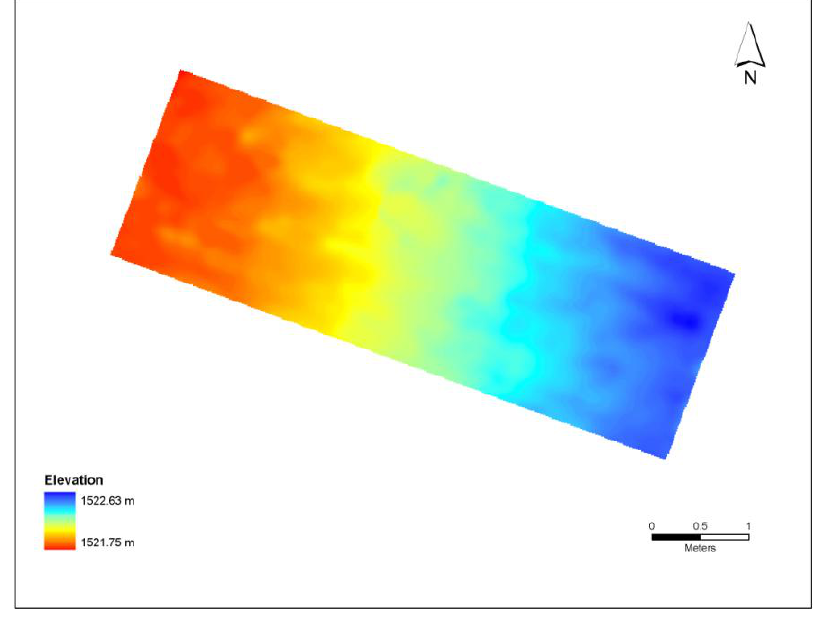
Figure 8. Bare earth DEM at 1 cm resolution. The vegetation was removed from the DSM and deleted areas filled with focal mean